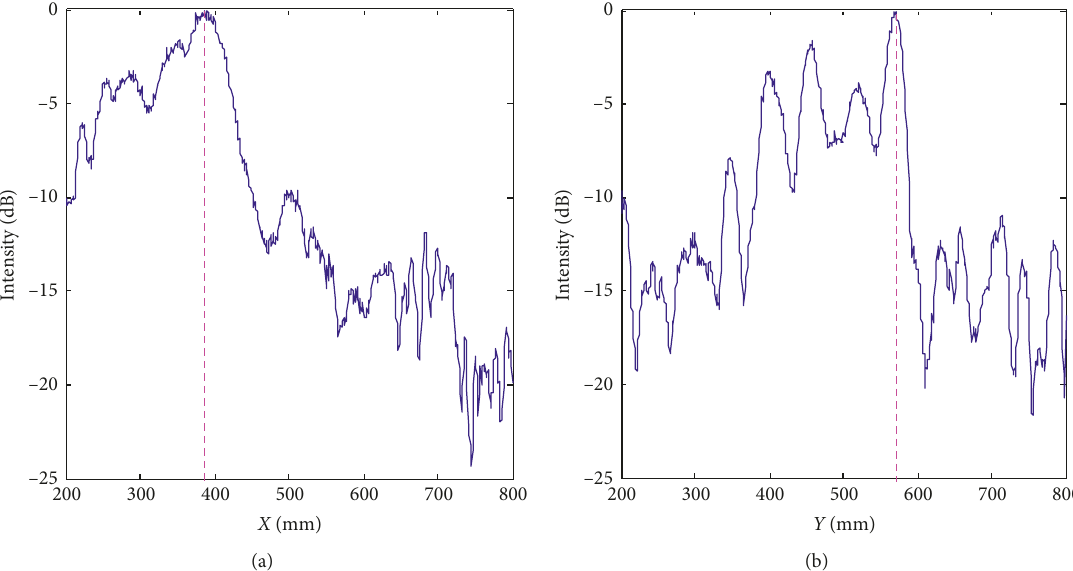
Figure 13: SAFT imaging intensity profile in (a) the X direction of the point (388 mm, 572mm) and (b) the Y direction of the point (388 mm,